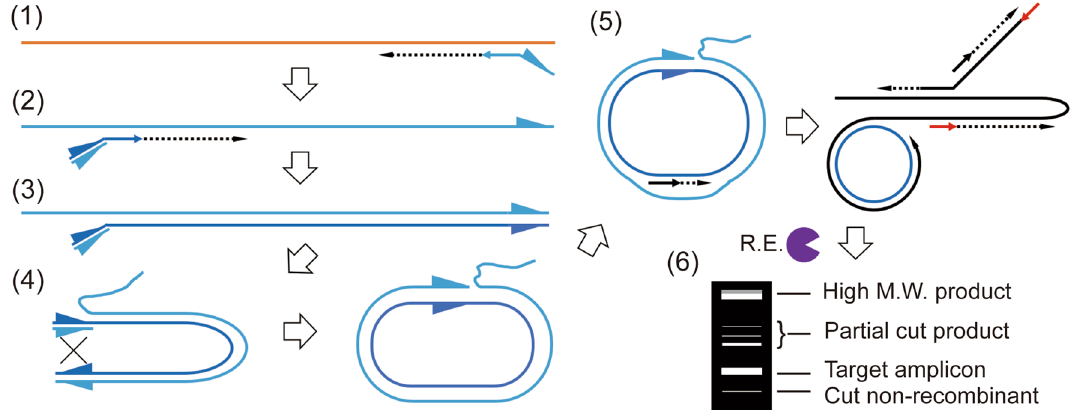
Figure 1. Process of CREA reaction. Numbered steps are described in the main text. loxP sequences are designated by right triangles so that the directionality of loxP sequences are indicated. In step (5), each RCA primer is indicated by black or red arrow. R.E. restriction